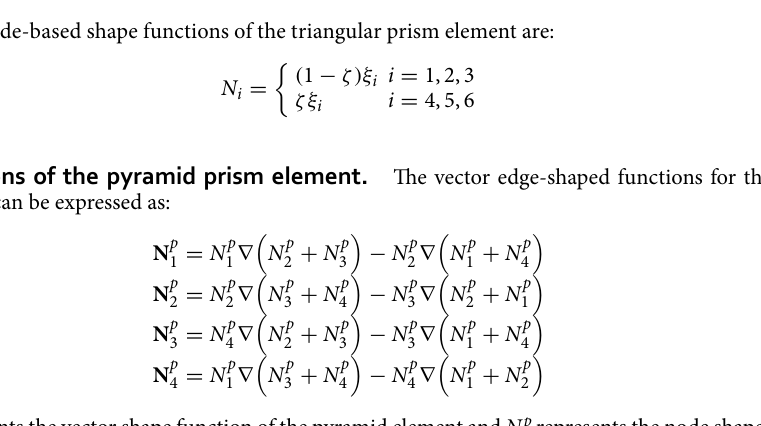
Figure 16. MT response calculation results of different meshes on survey line 1 to the terrain undulation model. ( a ) and ( b ) represent the MT response of the xy and yx components, respectively. ( a 1) and ( b 1) represent the apparent resistivity, and ( a 2) and ( b 2) represent the phase